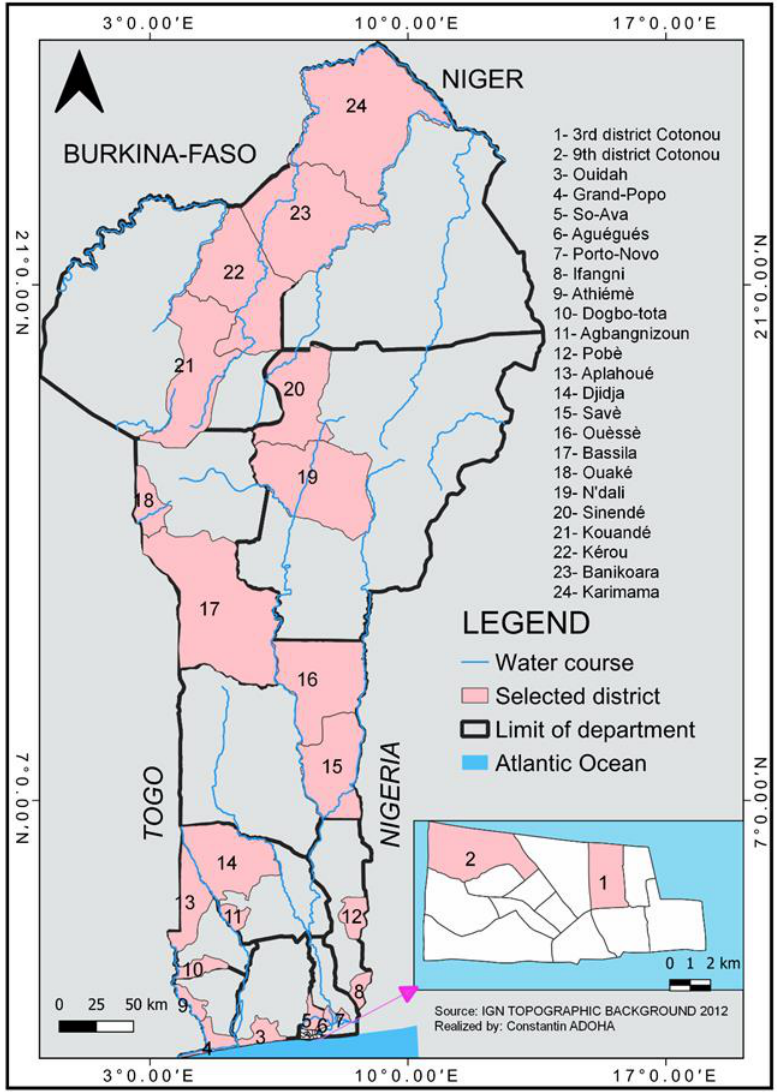
Figure 1. Map of Benin showing the different study sites.